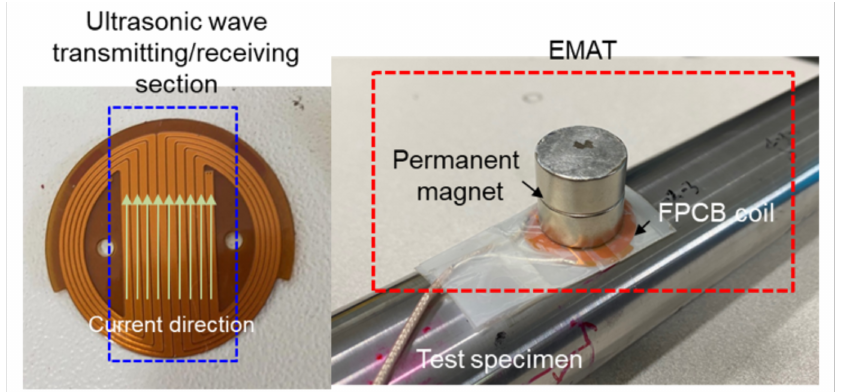
Figure 7. Coil and EMAT configuration used in the experiments.